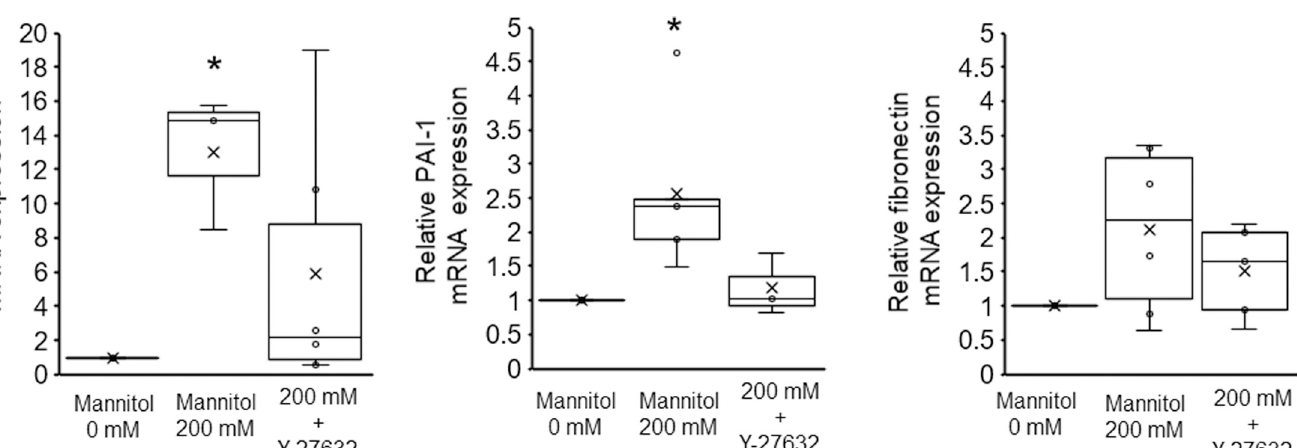
PLOS ONE | https://doi.org/10.1371/journal.pone.0261345 December21,